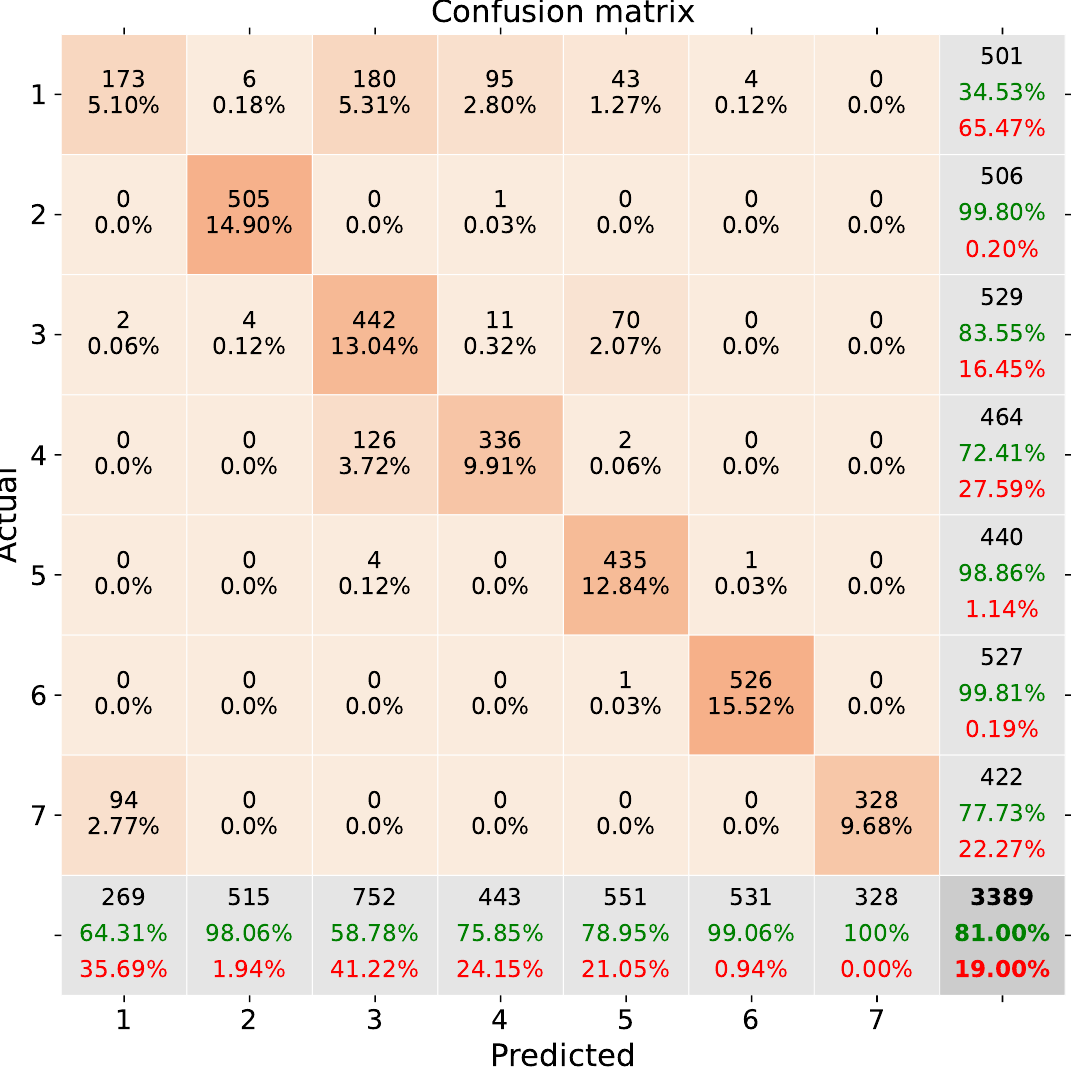
Figure 6. Confusion matrix summarizing the results obtained with the best model (two hidden layers, 128 neurons per